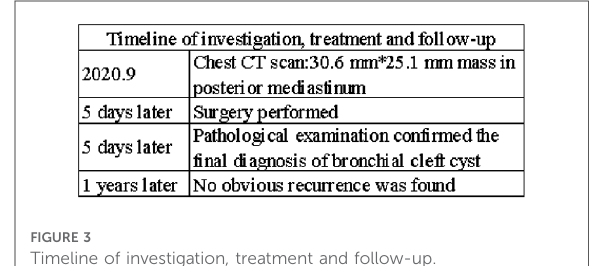
FIGURE 3 Timeline of investigation, treatment and